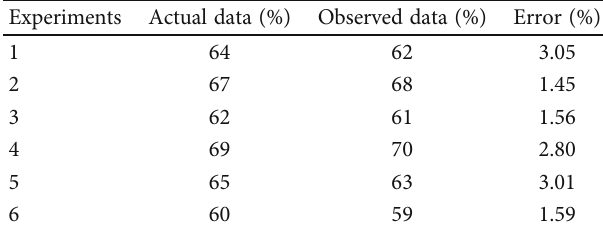
Table 4: Using of the analog machine (actual) for collecting data for body temperature.